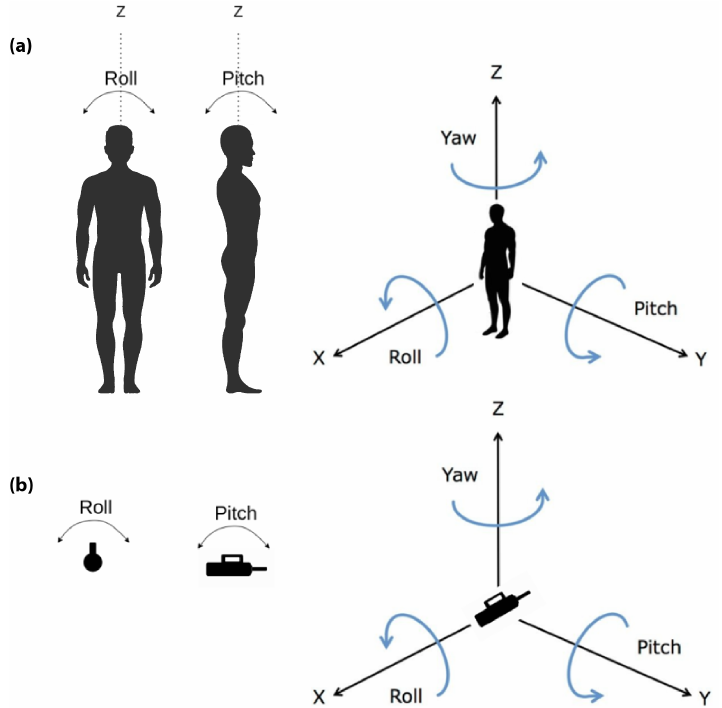
Figure 6. Reference frames for ( a ) the smart garment on the human and ( b ) the